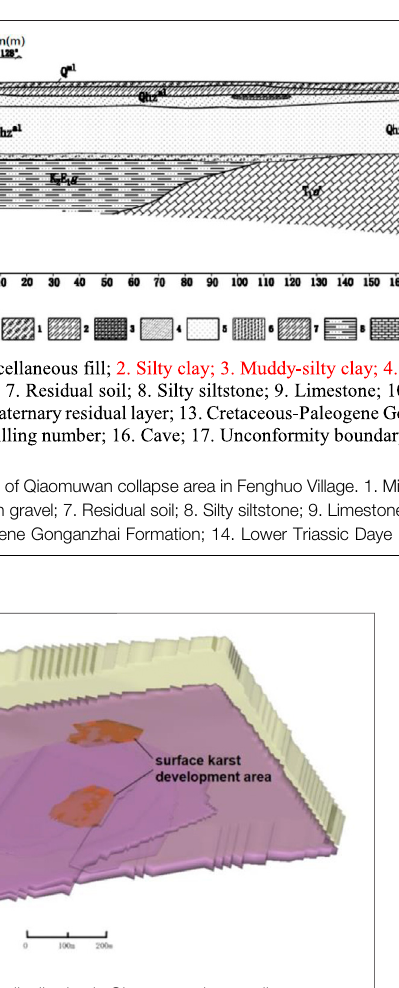
Frontiers in Earth Science |